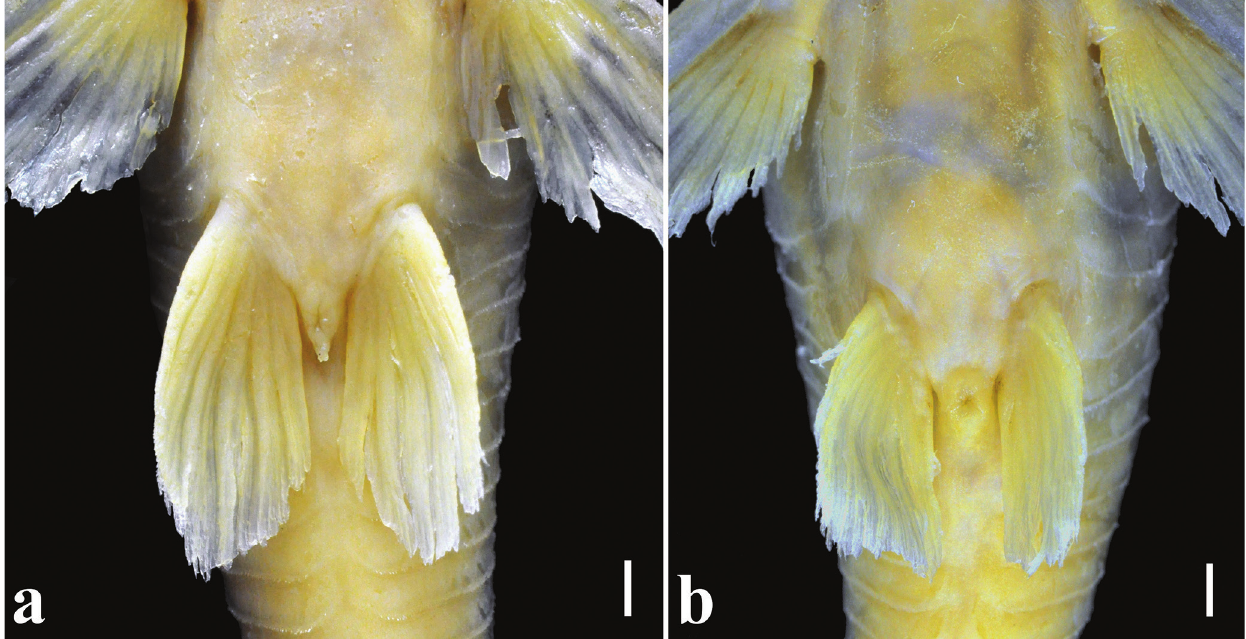
Fig. 9. Sexual dimorphism in Corydoras froehlichi , showing (a) the slender and more elongated pelvic fin on males, MCP 12945, 42.4 mm SL, paratype, and (b) the shorter and rounded pelvic fin on females, MCP 12945, 44.4 mm SL, paratype. Scale bar = 1.0